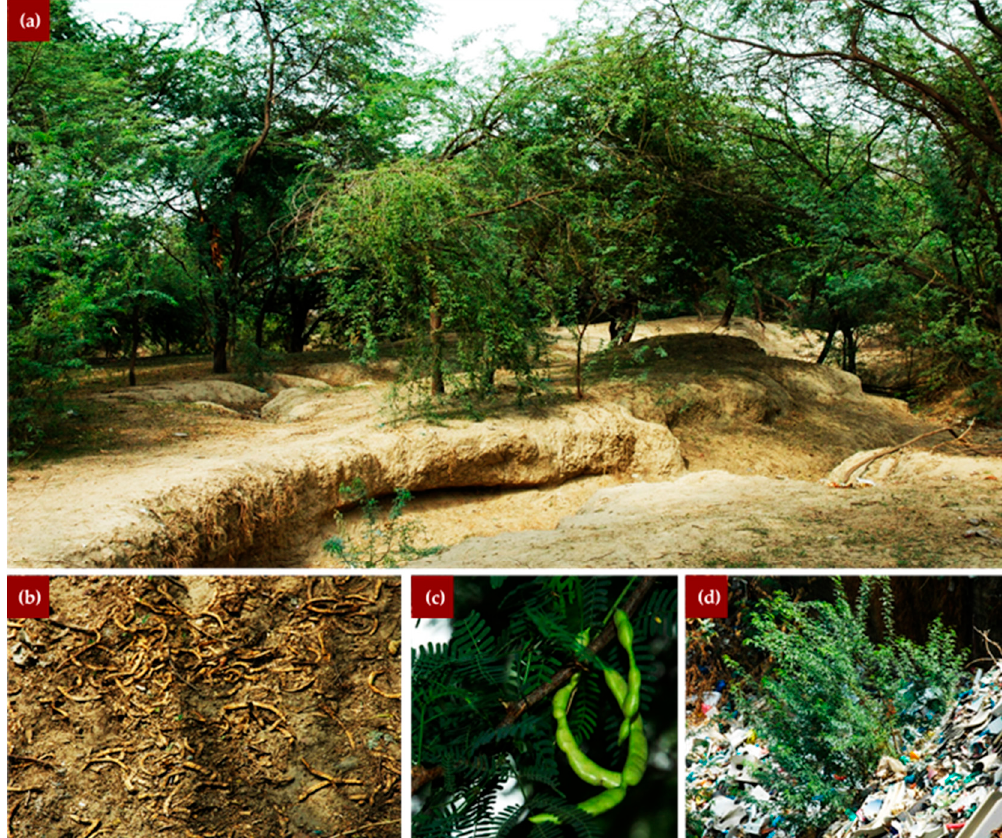
Figure 4. P. juliflora -invaded areas in Lucknow, Uttar Pradesh, India ( a ) Vast and spreading canopy of P. juliflora along with its string competition potential completely eliminate the ground flora; ( b ) Litter and ( c ) Pods of P. juliflora contain allelopathic chemicals ( d ) and its strong adaptation potential to grow in diverse habitat including plastic waste dump yards.